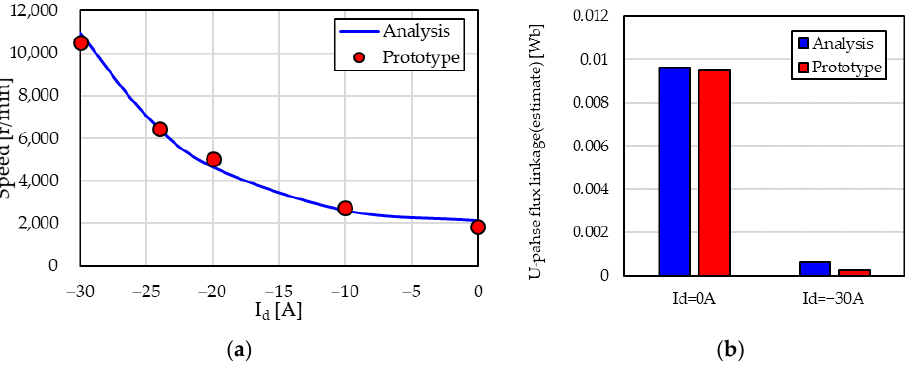
Figure 21. Adjustable flux by d-axis current: ( a ) Relationship between the rotating speed with re- spect to the d-axis current; ( b ) Estimated U-phase flux linkage in the prototype motor at no load and I d = −30 A .